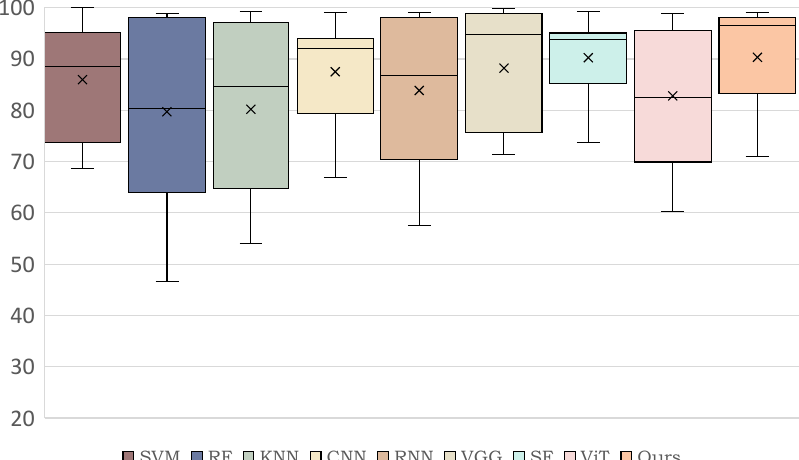
Figure 7. Box plot classification analysis of each algorithm on Pavia University.